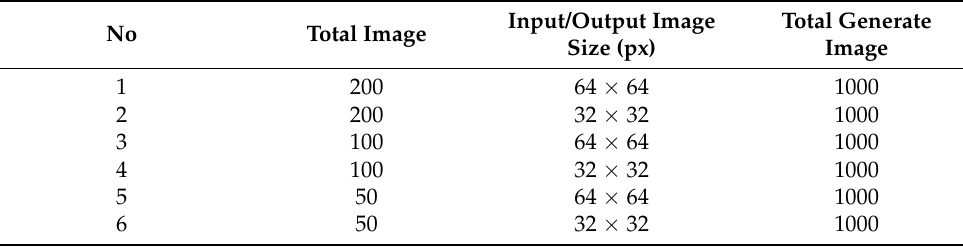
Table 2. GANs’ Experimental